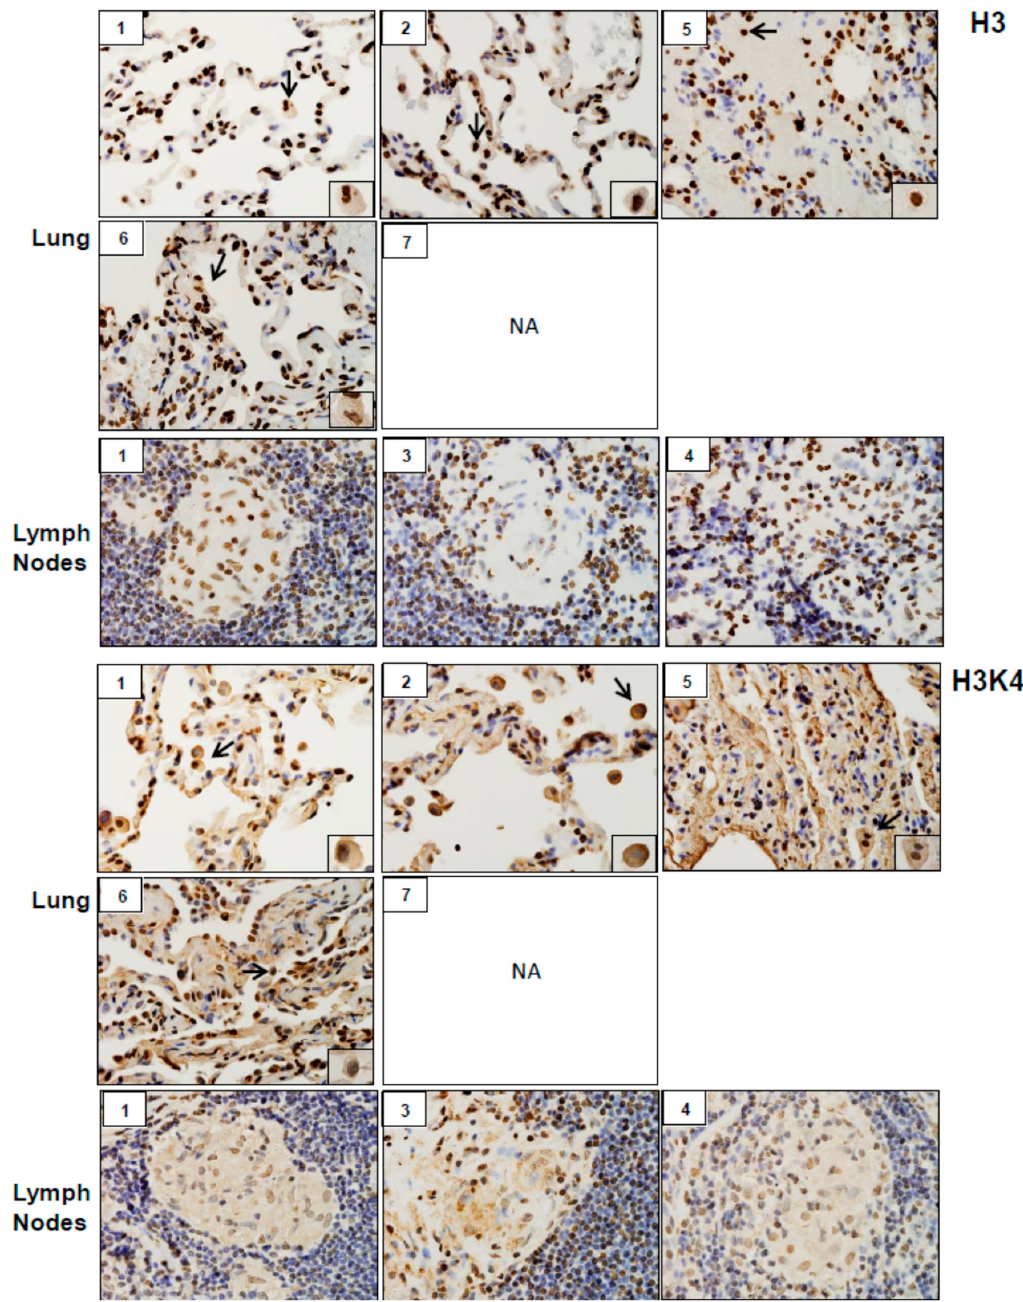
Figure 9. Histone H3 and methylated (K4) histone H3K4 expression in lung and/or lymph nodes collected from WTC rescue and recovery workers. Sections were immunostained with antibody to H3 or H3K4. Binding was visualized using a DAB peroxidase substrate kit. One representative section from each patient is shown. Inset, patient number; NA, tissue not available. Magnification, 60×; arrows, alveolar macrophages.